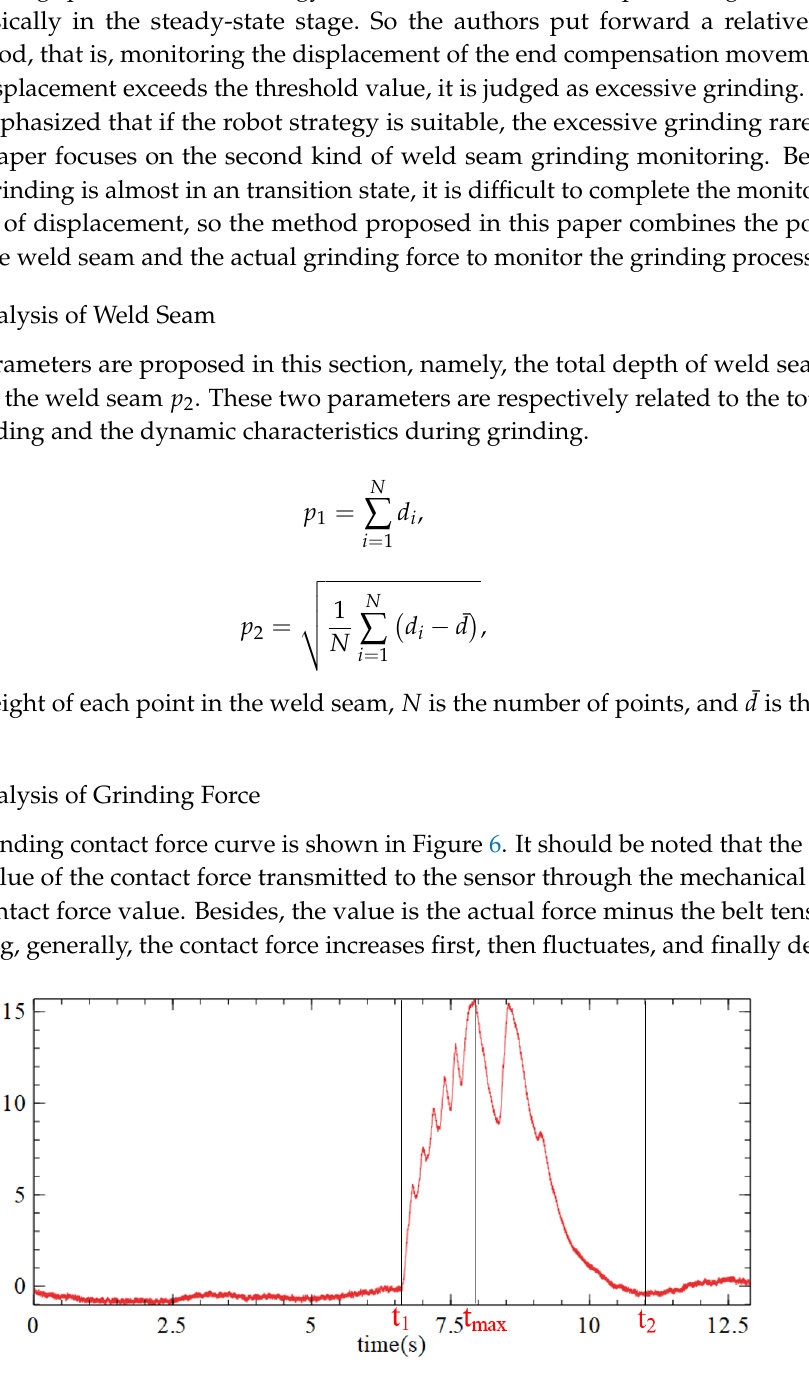
Figure 6. Typical curve and characteristic definition of grinding